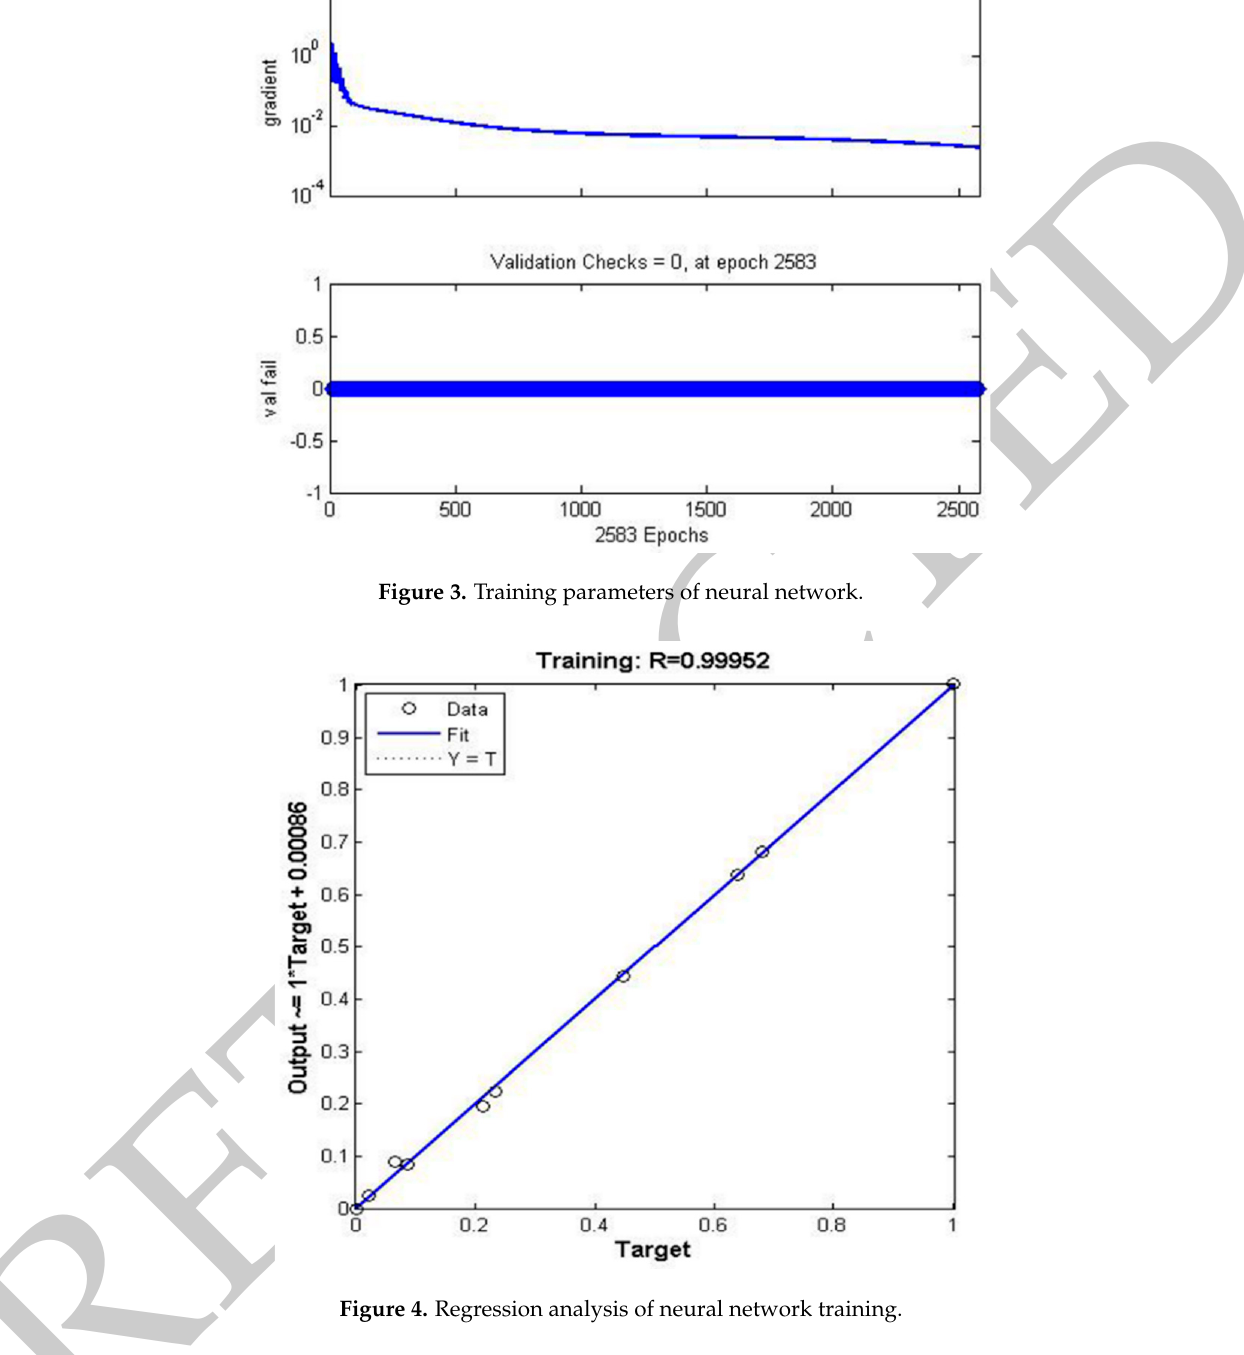
Figure 4. Regression analysis of neural network training.